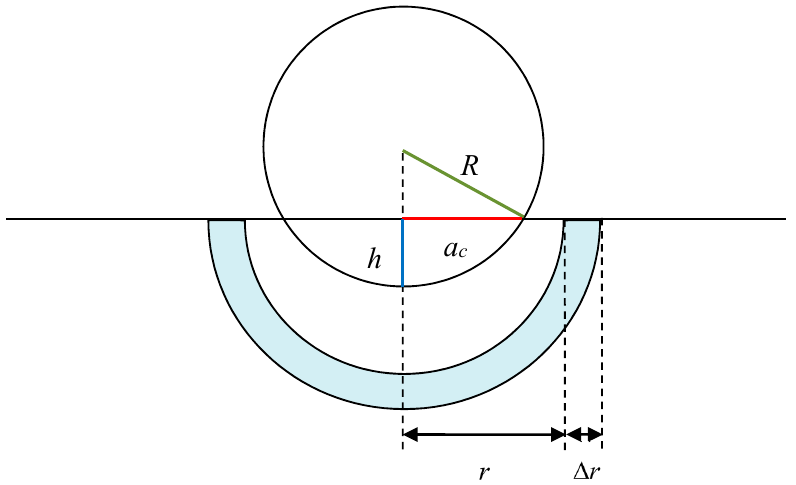
Figure 14. Schematic to evaluate the dislocation density.